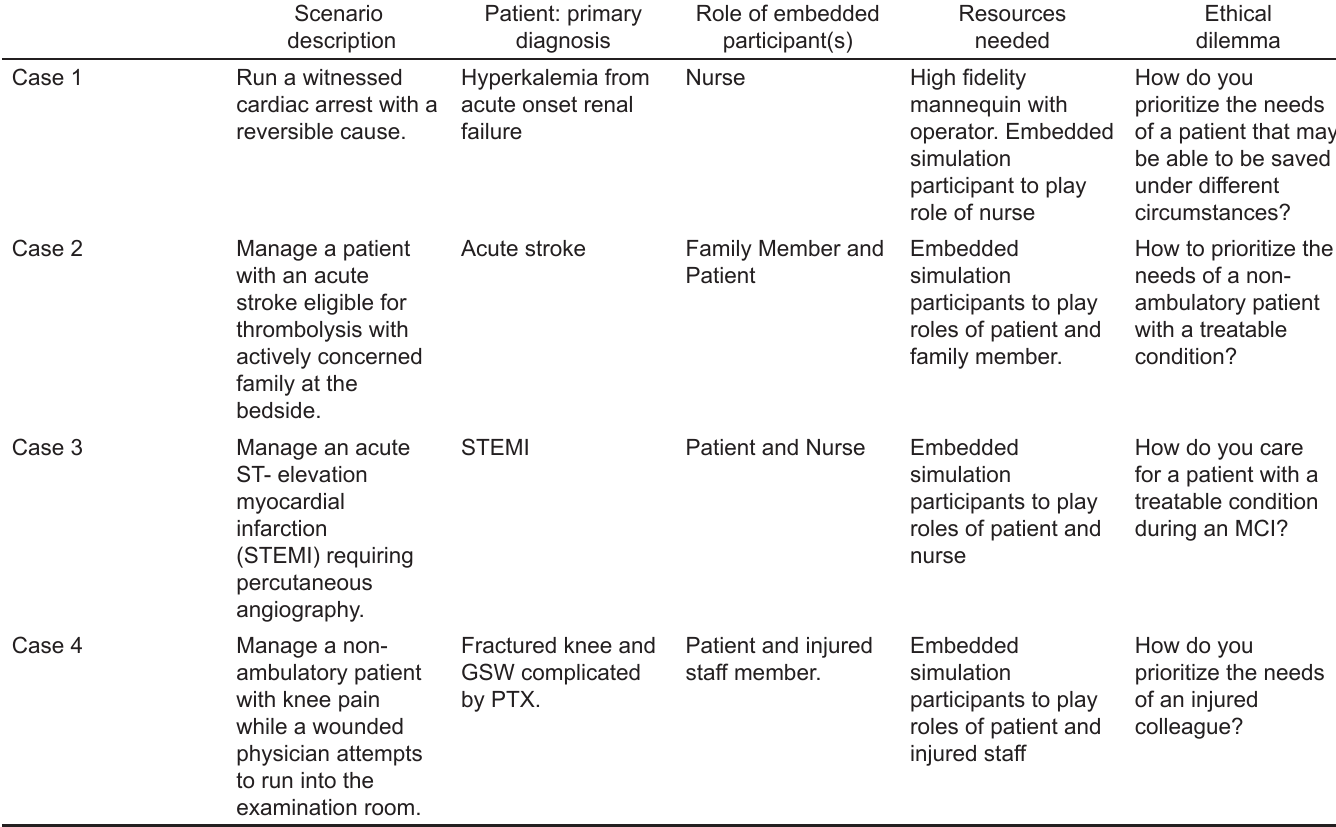
Table 2. Brief descriptions of simulation scenarios including primary patient diagnosis, role of embedded participants, resources needed, and pertinent ethical